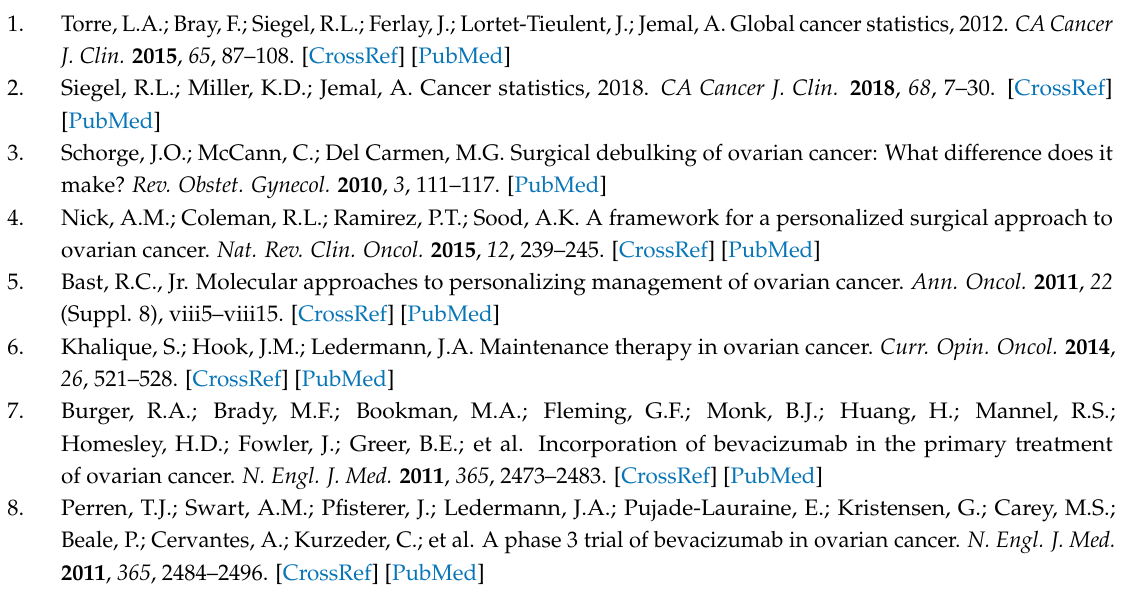
Figure S1: Expression of phosphorylated-SMAD2 across animal models. Protein lysates were extracted from untreated OV8-CDX, PH003, and PH095 models and western blot were performed to assess the expression of p-SMAD2. Total SMAD2 was used as loading control; Table S1: PDX models minimal information